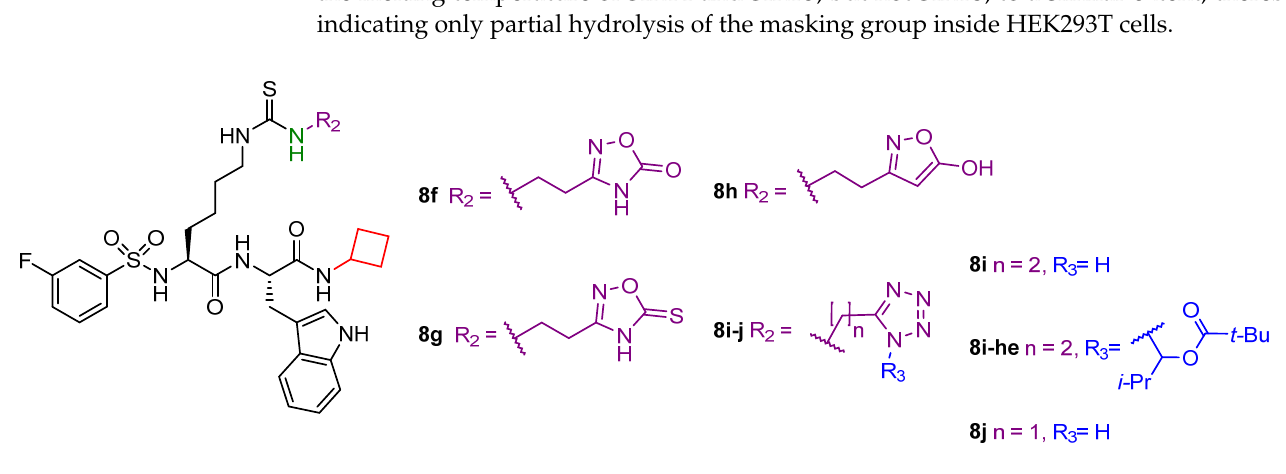
Figure 9. Structures of compounds 8f – j and 8i ‐ he .